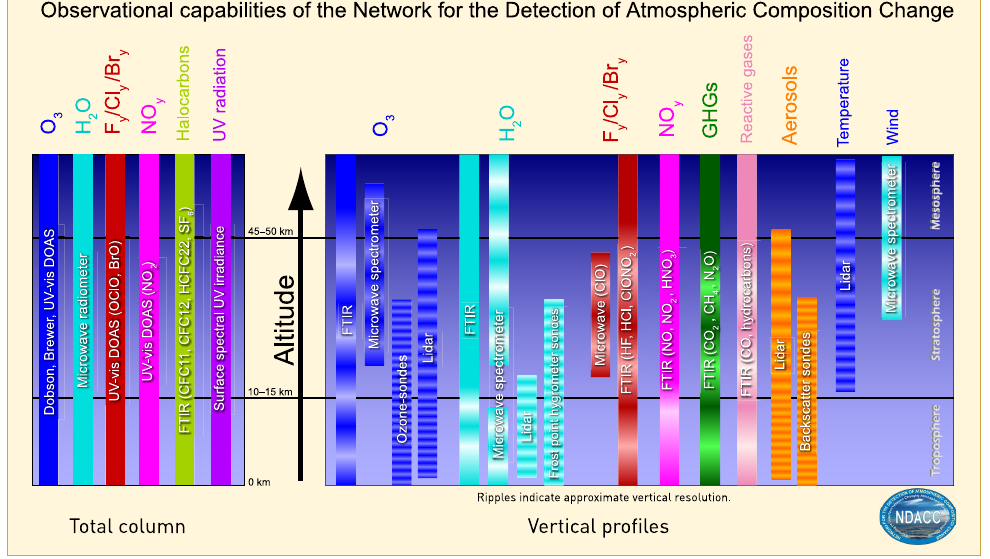
Figure 1. NDACC measurement capabilities, including species and parameters measured, instrumental measurement techniques, and each measurement’s approximate vertical resolution (indicated by the